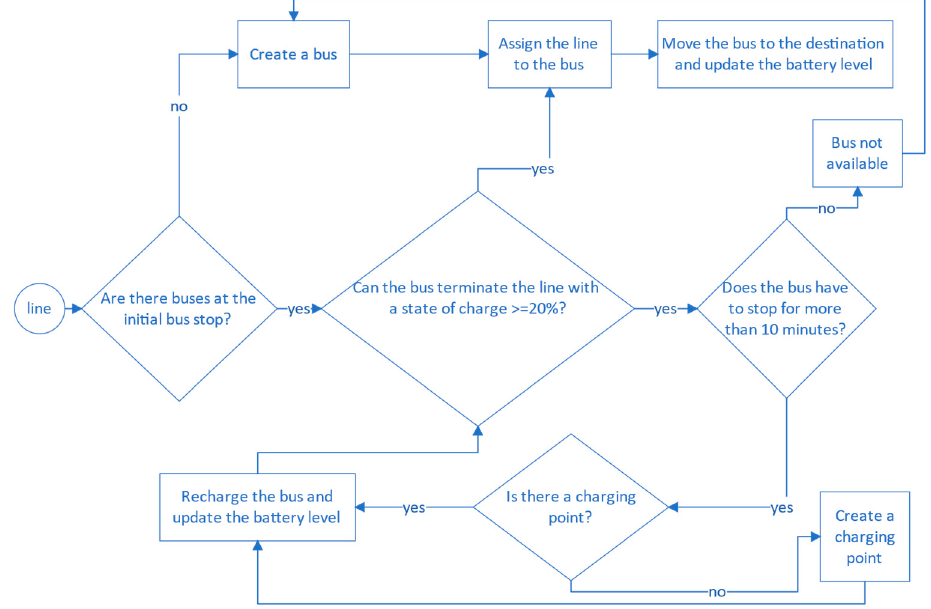
Figure 2. The algorithm that describes the tool’s decision-making process.